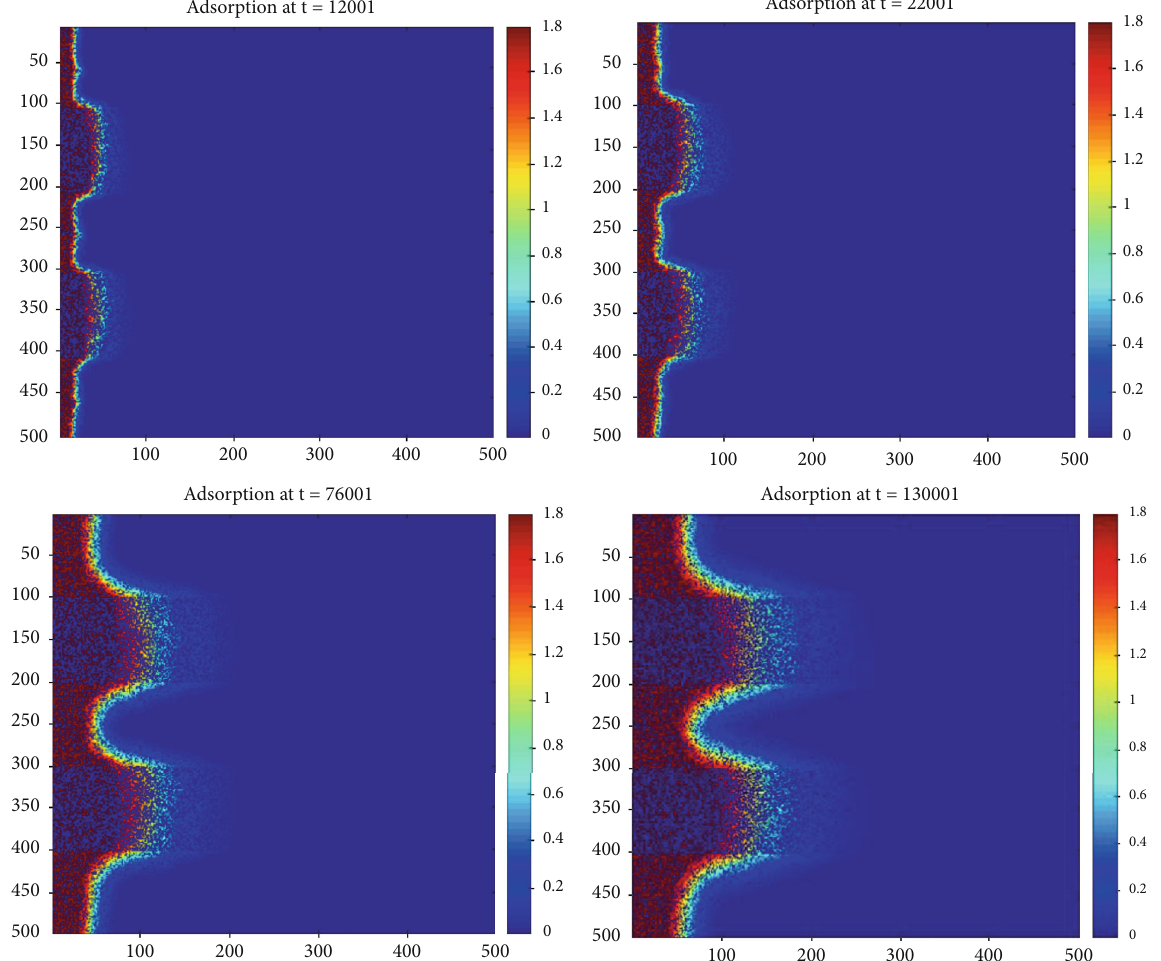
Figure 3: Adsorption distribution at time steps 12000, 22000, 76000, and